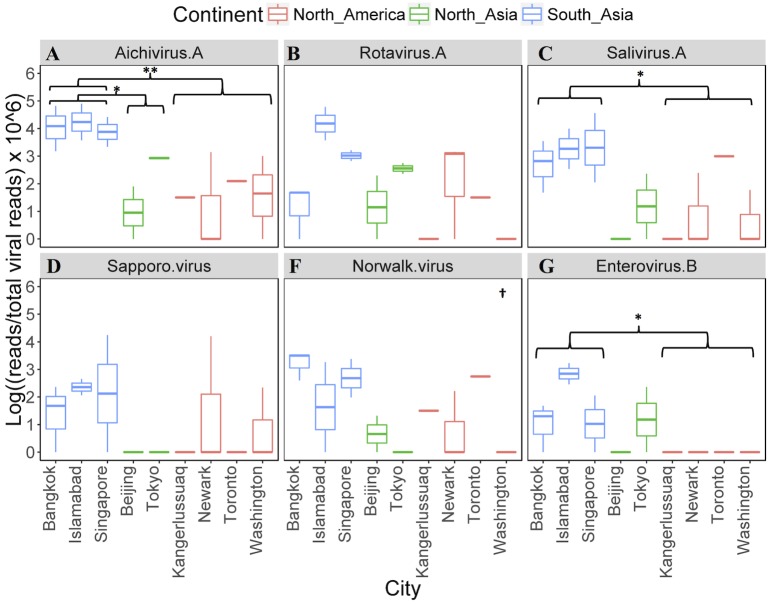
Enteric viruses detected in the sewage from the 19 airplanes.The airplane samples are grouped according to their departing city (n = 1–3). The y-axis was log-transformed viral reads per million (VRPM). For the statistical analysis, the cities were grouped according to their assigned region, and tested for significance using the Kruskal-Wallis rank sum test. If significant, the pairwise significance was determined using the Wilcoxon test with Bonferroni correction for multiple testing. * = p-Wilcoxon < 0.05, ** = p-Wilcoxon < 0.01, † = p-Kruskal-Wallis < 0.05.